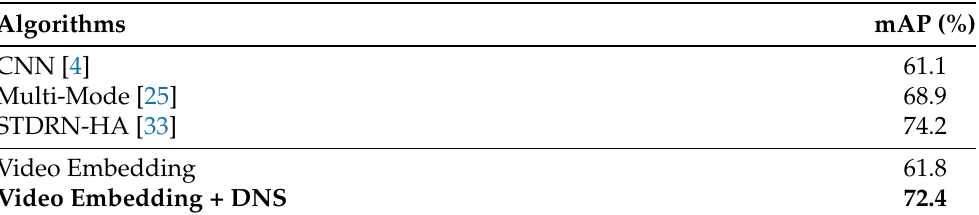
Table 2. Event detection performances of our continuous video semantic embedding model compared with the model integrated with discriminative negative sampling (DNS) on the CCV dataset.